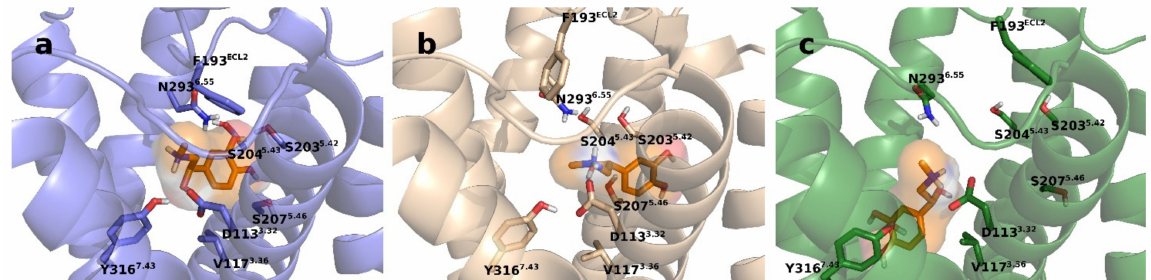
Figure 1. Ligand position in the orthosteric binding pocket in the 1st ( b ) and 2nd ( c ) replica simulations of the active β 2 AR–G s protein–epinephrine complex in comparison with the crystallographic structure (( a ), PDB code: 4LDO).